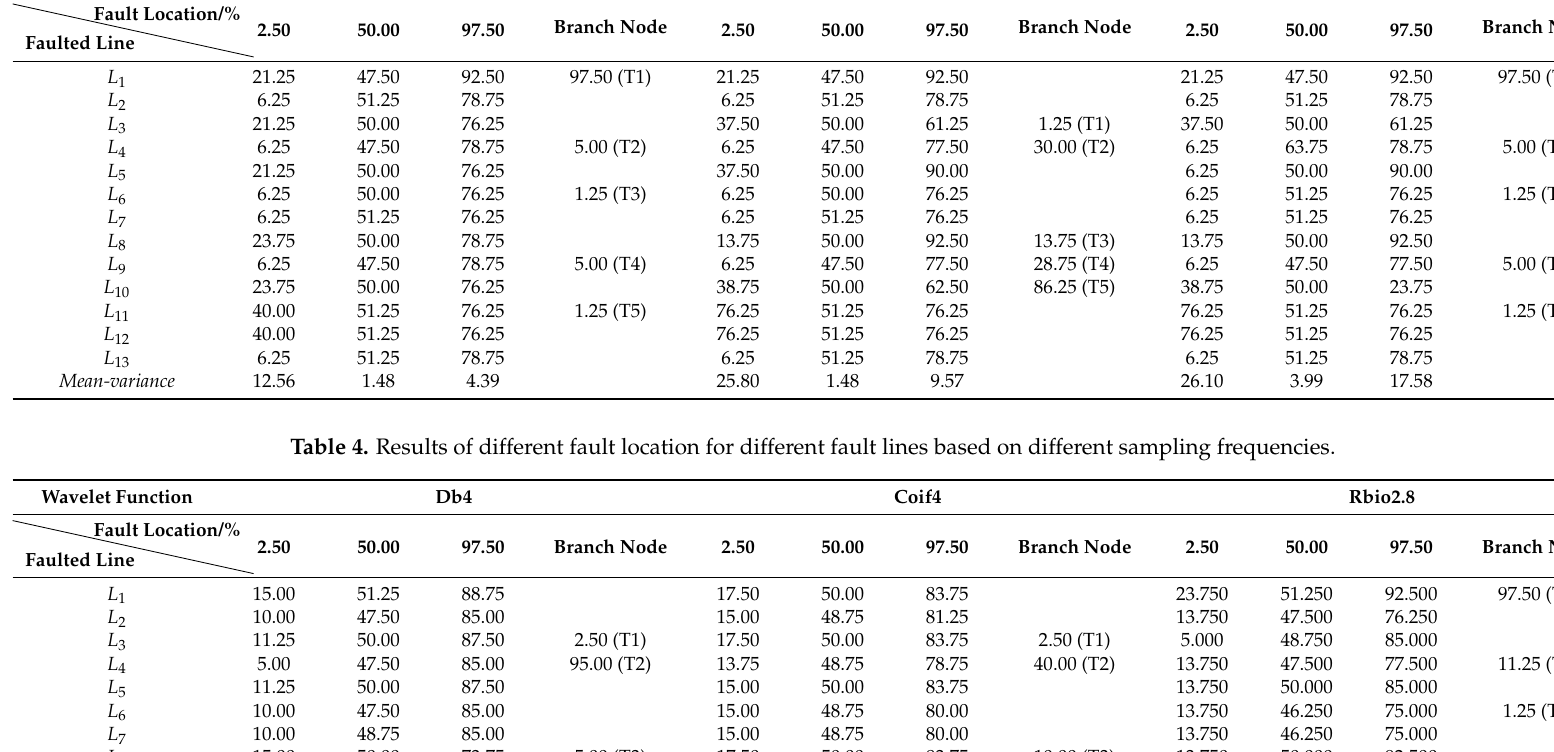
Table 3. Results of different fault location for different fault lines based on different wavelet functions. Wavelet Function Db4 Coif4 Rbio2.8 LineFault Location/% 2.50 50.00 Faulted